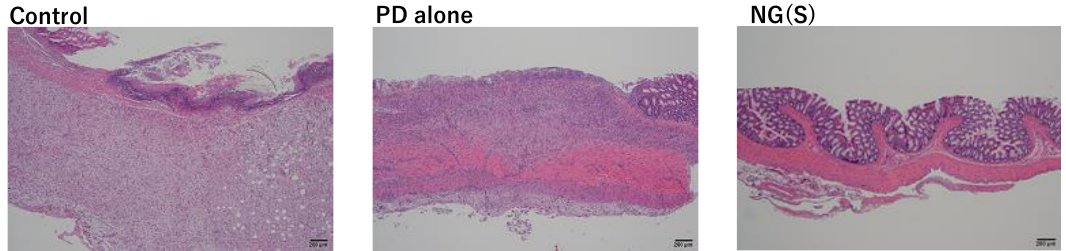
Figure 13. Representative H&E-stained distal colon sections at 10 mg PD eq./kg.